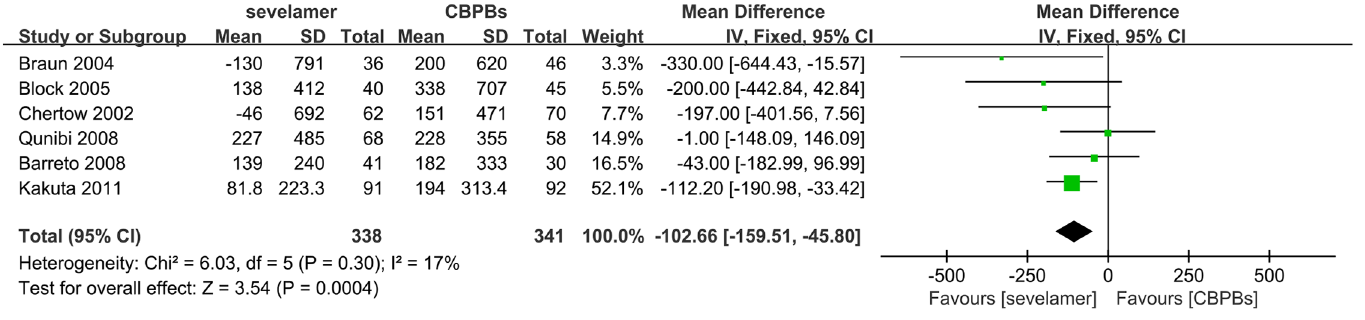
Fig 5. Forest plot of sevelamer vs. calcium phosphate binders on CACS change.